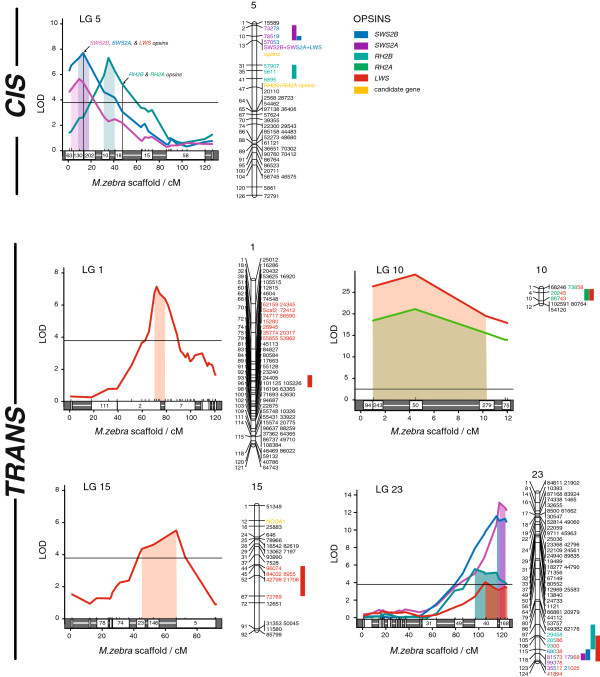
Prominent role for trans-regulatory divergence in the evolution of cichlid opsin expression. Divergence at 11 overlapping eQTL located both cis- (LG 5) and trans- (LGs 1, 10, 15, and 23) to the opsins contributes to interspecific differences in cichlid opsin expression and color vision (n = 115). eQTL on linkage group 5 are considered potential cis-regulatory loci given their linkage to the opsin genes on this chromosome; however, it is also possible that some or all of these regions contain diffusible regulatory elements that act in trans. LOD plots of eQTL and their associated opsins are shown for significant eQTL only. Horizontal bars represent the 95th percentile of genome-wide LOD scores (LOD = 3.7) and colored rectangles delineate the 95% Bayesian confidence intervals for each eQTL. Tic-marks above the x-axis indicate the position of each genetic marker, while the white boxes indicate the genomic scaffolds that these markers map to within the Metriaclima zebra cichlid genome assembly (not to scale). A linkage map with marker names is shown to the right of each LOD plot. Colored bars and highlighted marker names correspond to the 95% Bayesian confidence intervals shown in the LOD plots (for LG 10, drop 2-LOD are used).